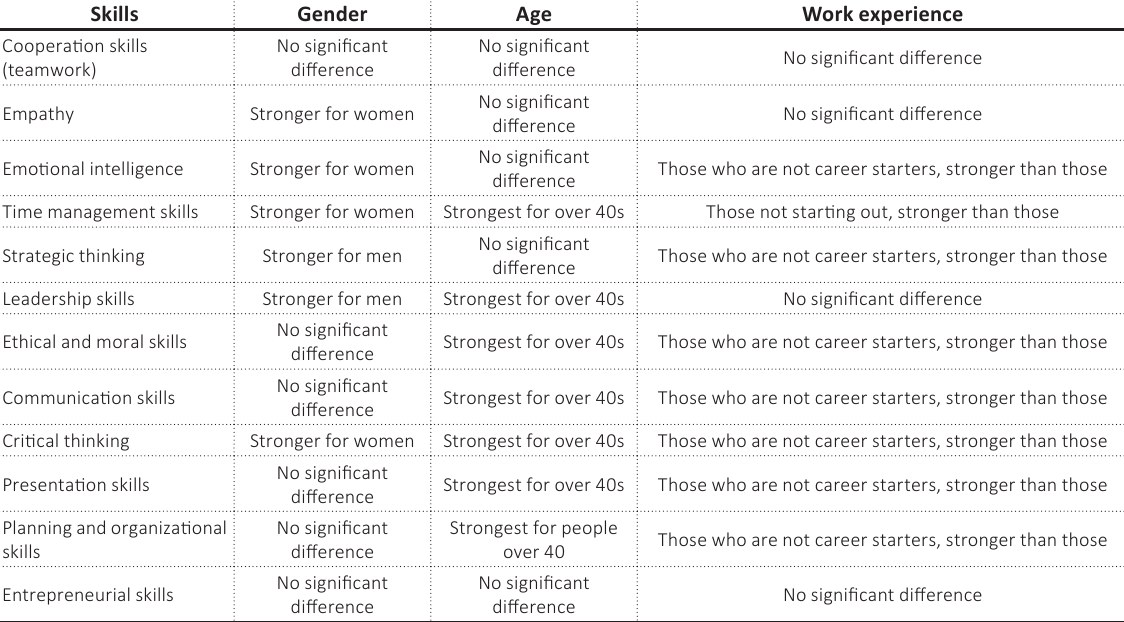
Table 5. Differences in skills by gender, education, and age Gender Age Work